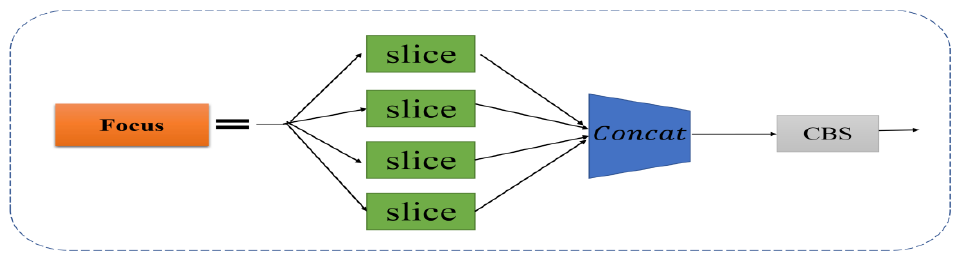
Figure 2. Focus network structure. The structure is mainly to slice the feature into four parts, and then perform the Concat in the channel dimension.